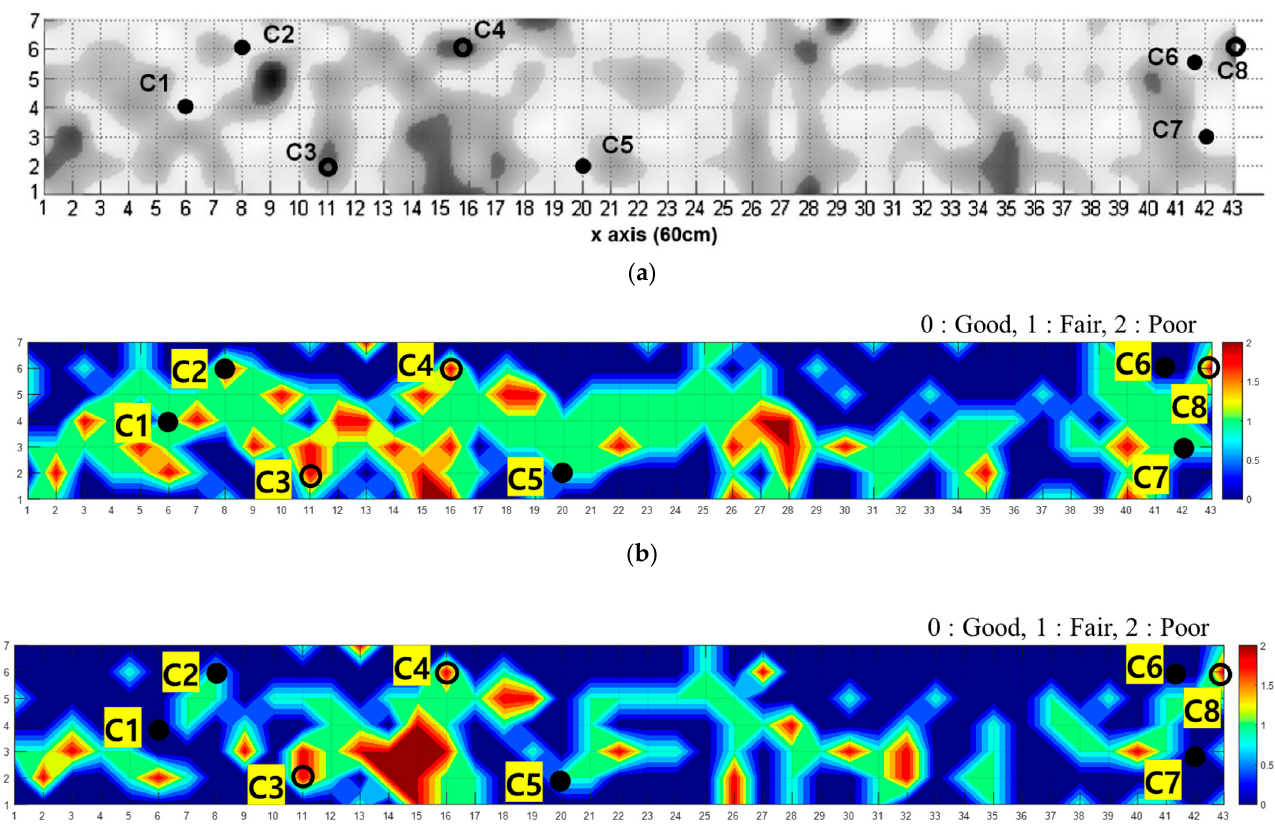
Figure 13. C-scan images for IE data collected from the bridge deck; spectral data are displayed up to 6 kHz. The closed and open circles are the positions of the good and poor cores, respectively. ( a ) Overlapped images of four NDT results analyzed by experts (image courtesy: Taekeun Oh), ( b ) prediction result of the SL model, ( c ) prediction result of the SSL model. Table 3. Comparison of core test and prediction results.